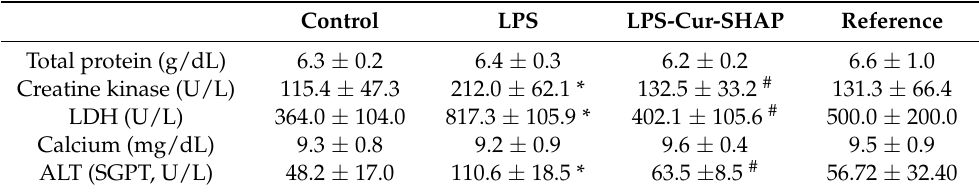
Table 2. Blood biochemical analysis of the serum concentration of total protein (TP), creatine kinase (CK), lactate dehydrogenase (LDH), calcium (Ca), and ALT (alanine aminotransferase). n = 6, * p < 0.05 compared to the control; # p < 0.05 compared to the LPS group. Reference: Charles River Laboratories, CD ® IGS Rat Model Information